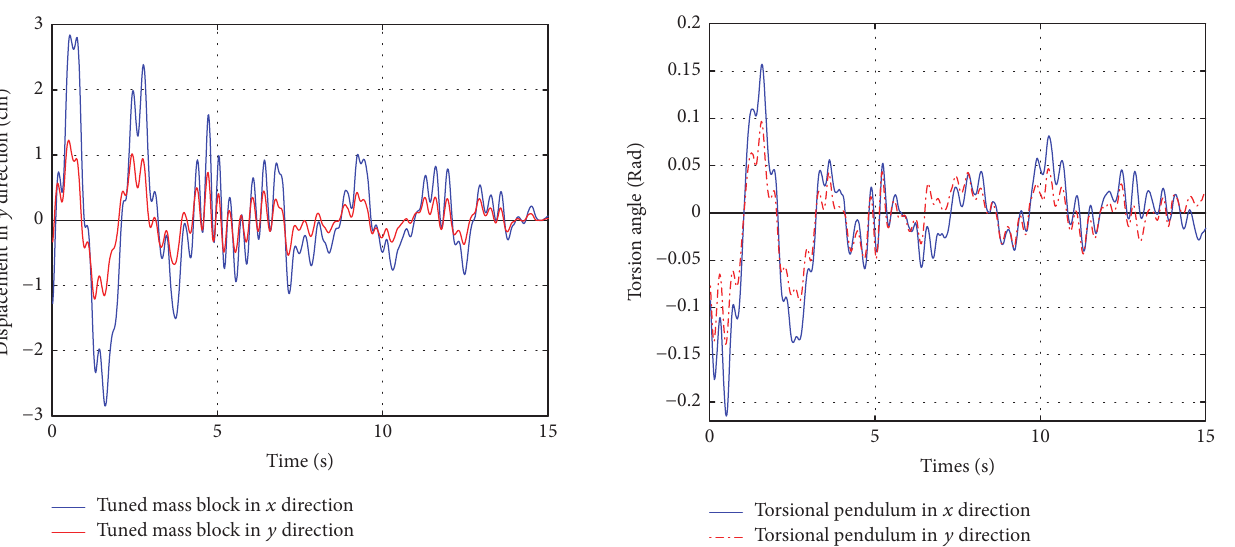
Figure 15: Torsion angle history of the torsional pendulums.